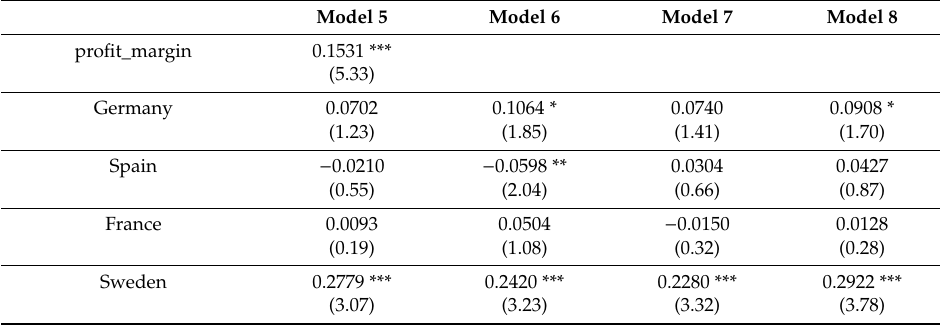
Table 5. Variables correlated with e ffi ciency, random e ff ects estimations. Dependent variable is e ffi